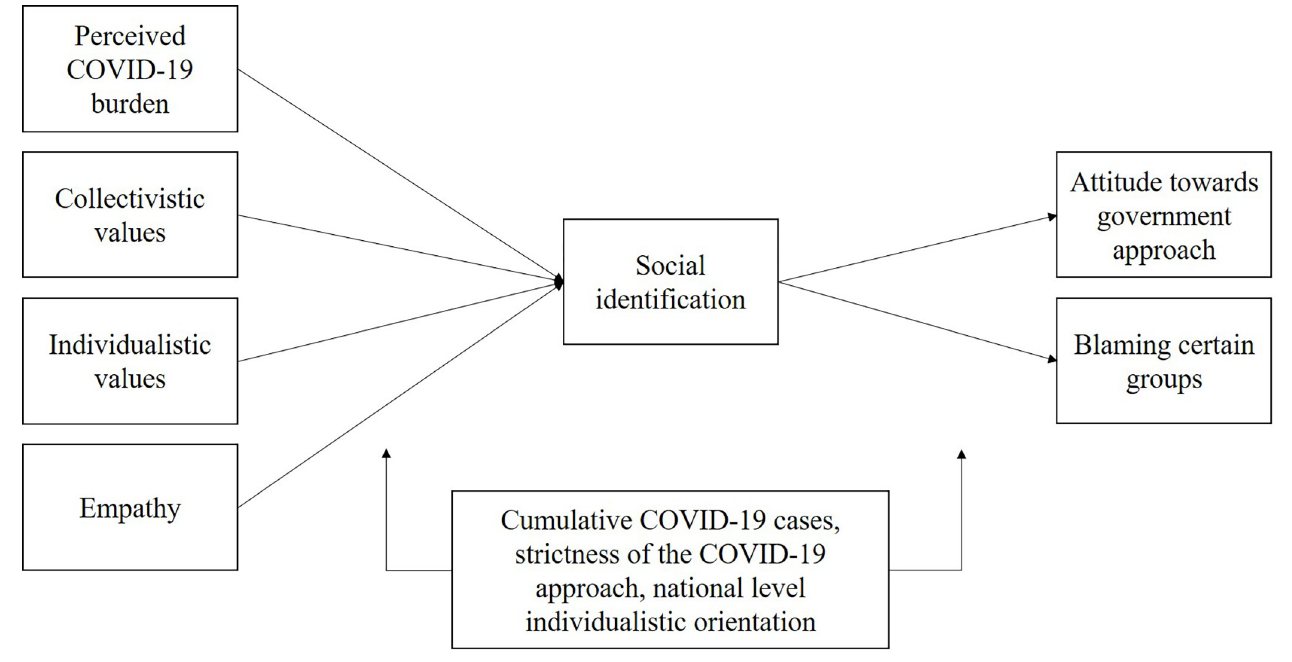
Fig 1. Conceptual model of the studied